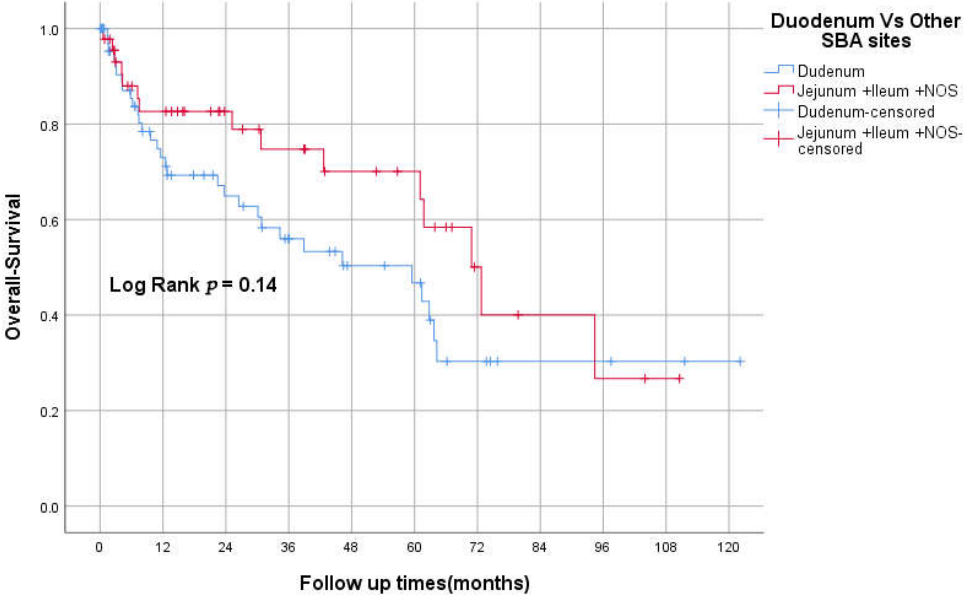
Figure 3. Kaplan–Meier curve of Recurrence-free survival for stages I-III.